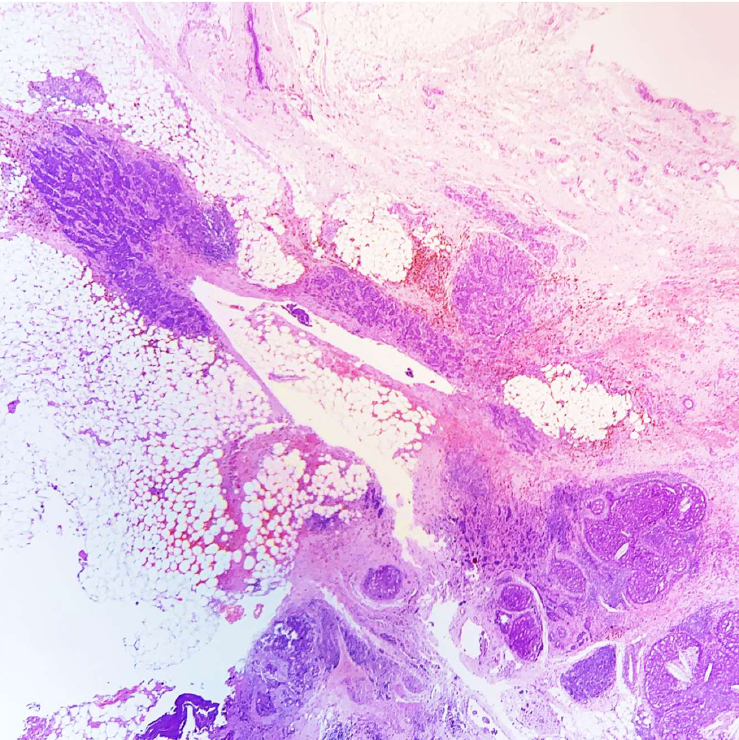
Figure 3. Histological section from quadrantectomy specimen showing fibrous reaction in the site of previous biopsy, along with foci of ductal carcinoma in situ and residual invasive carcinoma (HE, 25×).